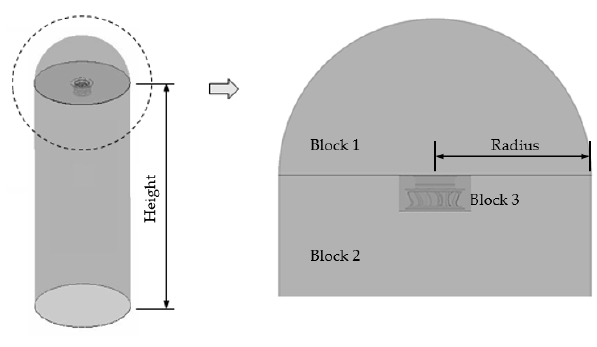
Figure 2. Computational domain.